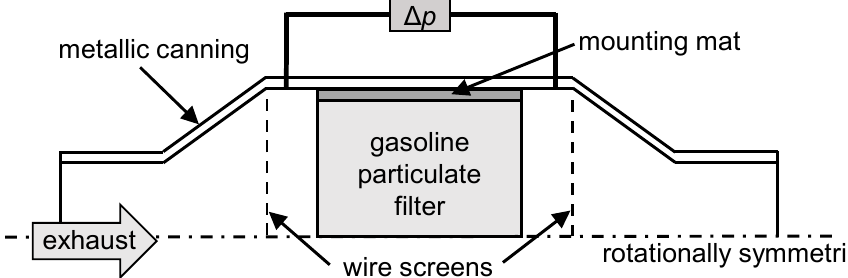
Figure 1. Schematic layout of the simulation model. The wire screens are used to exactly define the cavity resonator in the radio-frequency (RF) simulation.